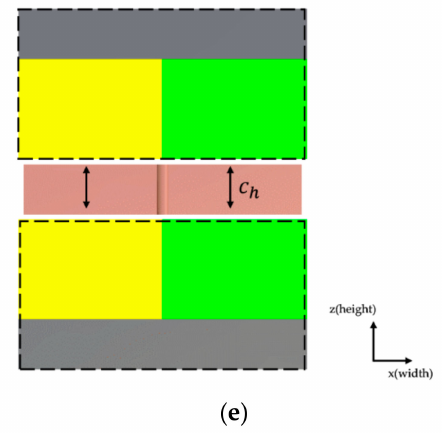
Figure 2. Variations of the horizontal force voice coil motor (HVCM)’s structure according to changes in the design parameters: ( a ) case (a), change of magnet width; ( b ) case (b), change of VCM width; ( c ) case (c) change of VCM length; ( d ) case (d) change of magnet height; ( e ) case (e) change of coil